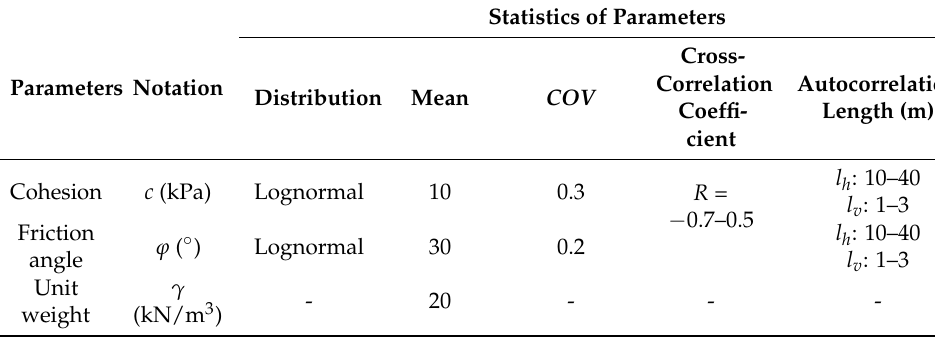
The realizations of cohesion and friction angle while considering the rotation of deposition orientations as 0 ◦ , 45 ◦ , 90 ◦ , and 135 ◦ were presented firstly, as shown in Figure 6. It should be noted that the rotation was counterclockwise. The horizontal and vertical autocorrelation lengths were respectively considered as 40 m and 3 m. The co- hesion and friction angles were negatively correlated, and the cross-correlation coefficient was set to be − 0.5. It can be observed from Figure 6 that a low value of cohesion was associated with a high value of ϕ and vice